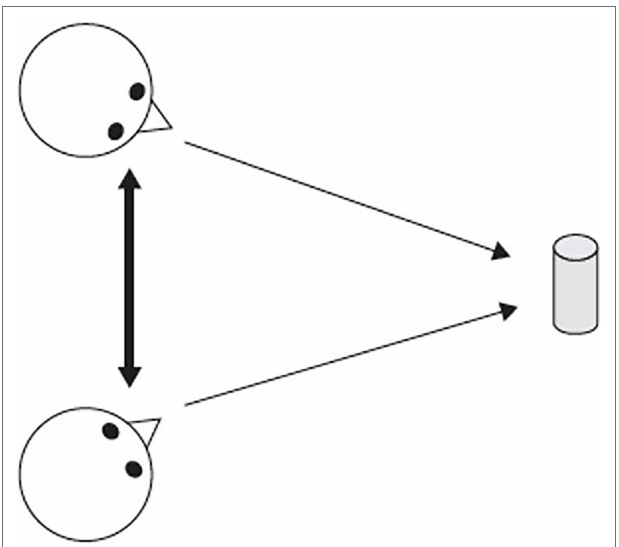
FIGURE 2 | The joint attention triangle. The bold arrow represents how two individuals “know together” that they are sharing attention to the same object. Adapted from Figure 2.1 of Carpenter and Call